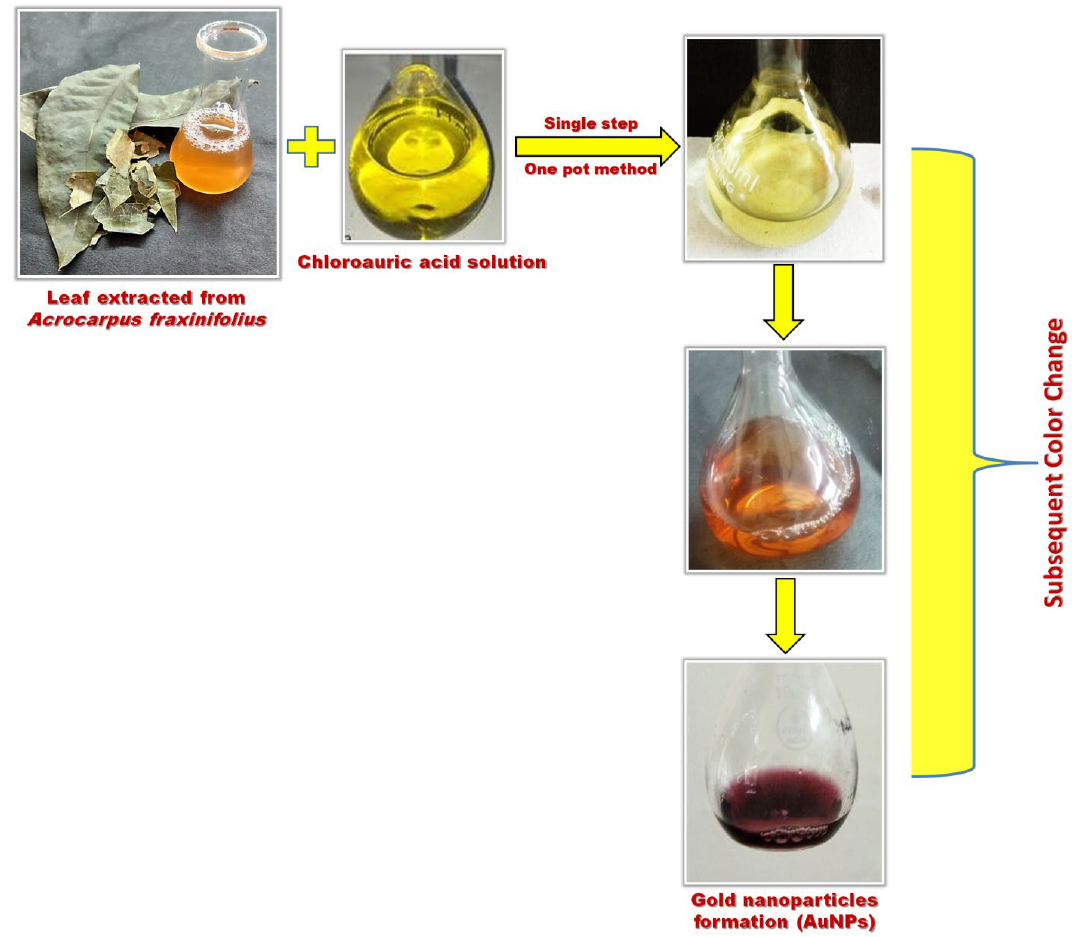
Scheme 2. One pot green synthesis of gold nanoparticles